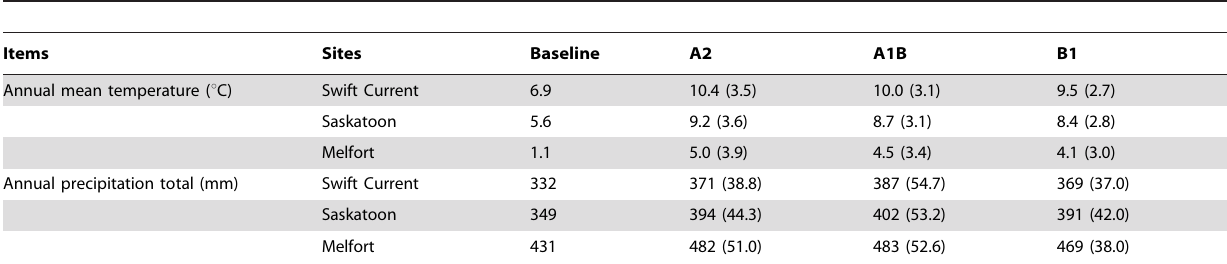
Table 4. Mean annual temperature and precipitation total of baseline and three scenarios for 2050s.